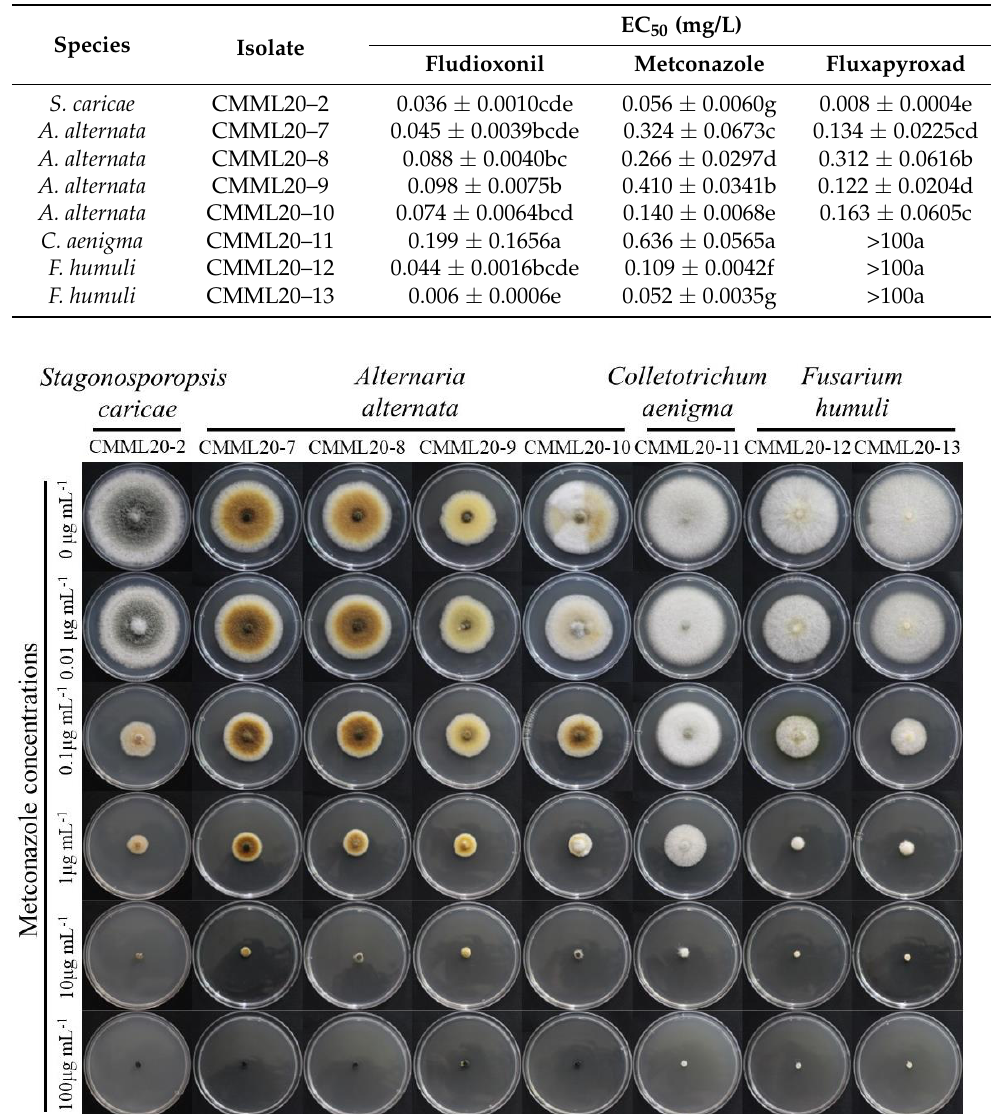
Figure 9. Anterior view of colonies of all fungal isolates on non-supplemented PDA and sup- plemented with 0.01, 0.1, 1, 10, or 100 μg mL − 1 of fludioxonil.